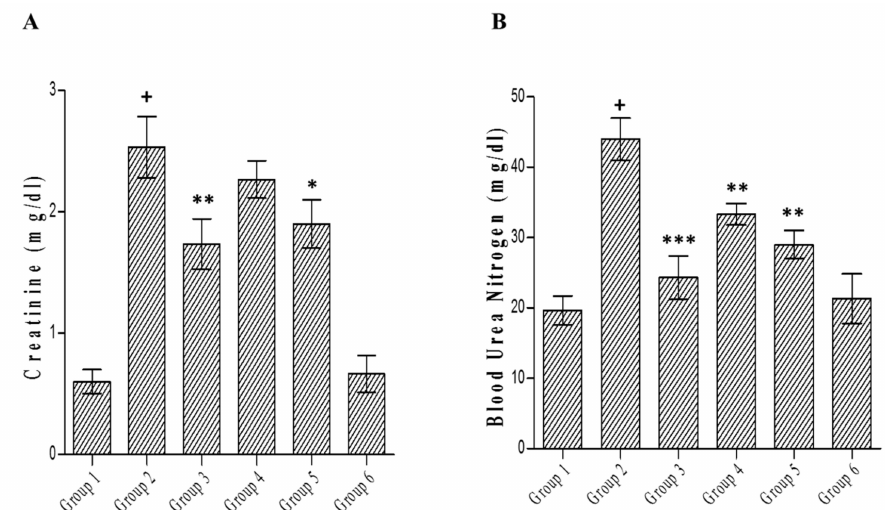
Figure 9. E ff ect of C. lanceolatus methanolic extract on serum creatinine ( A ) and blood urea nitrogen ( B ) levels. The results are expressed as a mean ± SD ( n = 5). Group 1: Normal control; Group 2: Diabetic control; Group 3: Diabetic rats treated with glibenclamide; Group 4: Diabetic rats fed with C. lanceolatus extract (200 mg / kg); Group 5: Diabetic rats fed with C. lanceolatus extract (400 mg / kg); Group 6: C. lanceolatus methanolic extract (400 mg / kg) control. + p < 0.001 compared to normal control. * p < 0.05, ** p < 0.01 and *** p < 0.001 compared to the diabetic